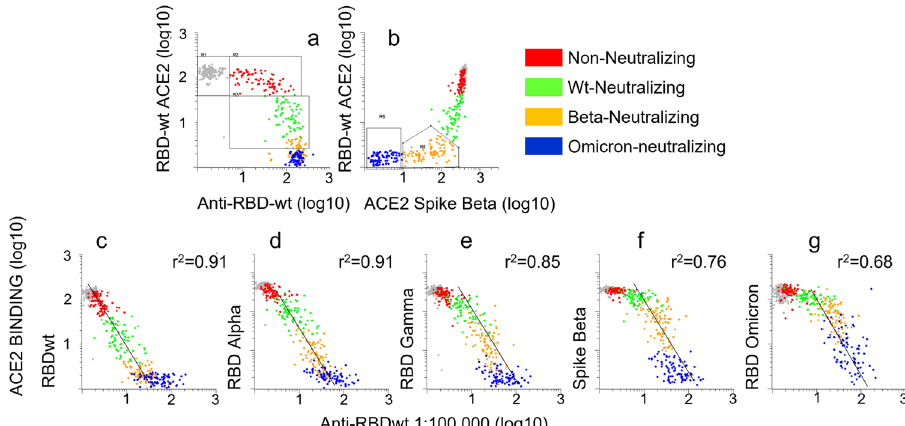
Fig. 6 Inhibitory effects of RBD-ACE2 interactions correlate with anti-RBDwt titers. a , b See legend to Fig. 5a, b. Each dot in the scatter plots correspond to a different sample. c – g The x -axes show binding of human IgG to RBDwt after incubation with serum diluted 1:100,000. The y - axes show binding of ACE2 to beads coupled with RBDs and spike proteins from indicated SARS-CoV-2 variant after incubation with serum diluted 1:100. The dot plots show accumulated data from array-based analysis of 550 sera. Each dot corresponds to a different sample. Pearson